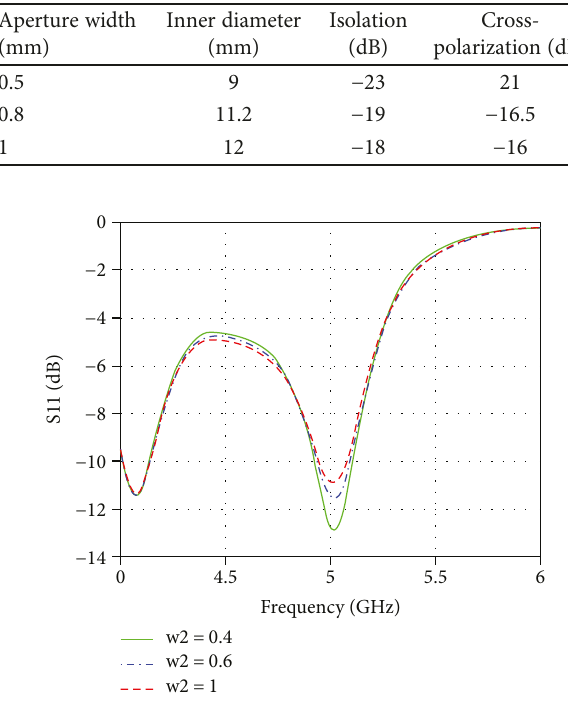
Figure 2: Curve of return loss of aperture circle varies with open loop feed wire width.